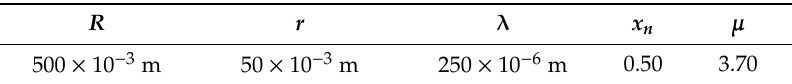
Table 1. The algorithm’s